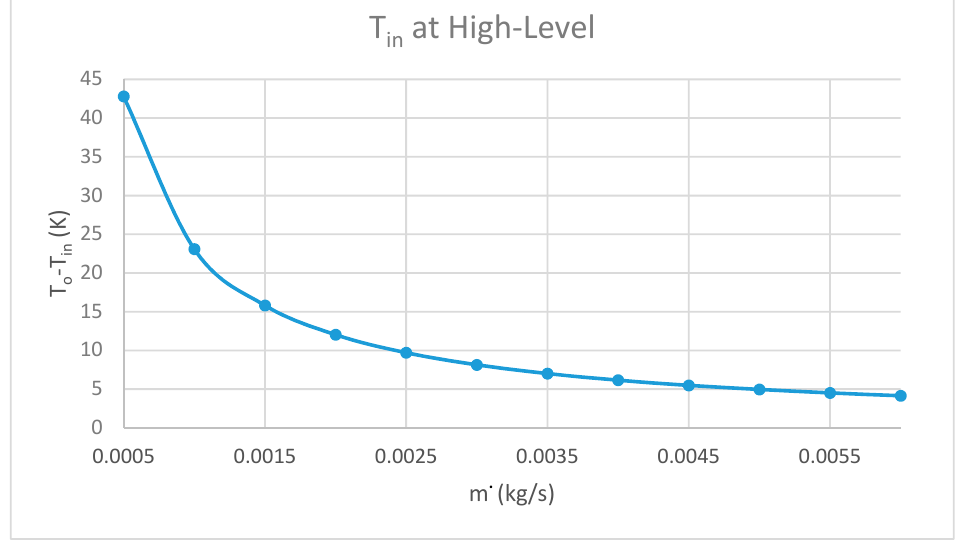
Figure 9. The effect of inlet flowrate on T o − T in at High-Level inlet temperature.